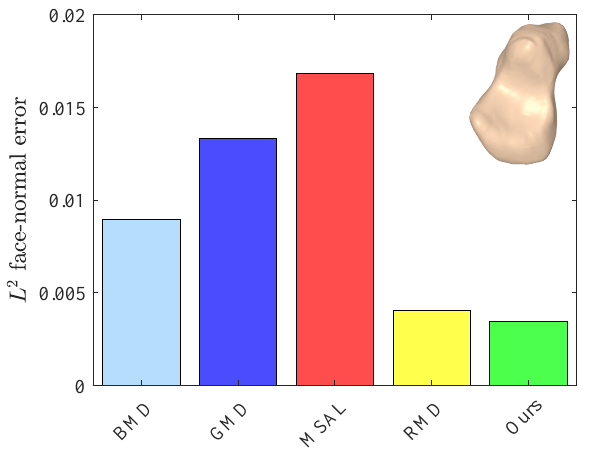
Figure 10. L 2 face-normal position errors for the scaphoid model.